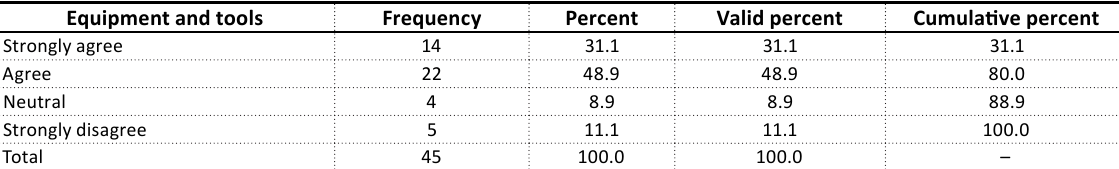
Table 2. Frequency showing the equipment and tools Equipment and tools